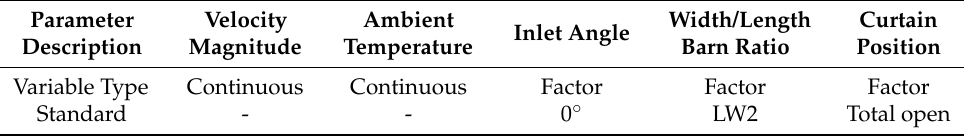
Table 3. Boundary conditions corresponding to flow